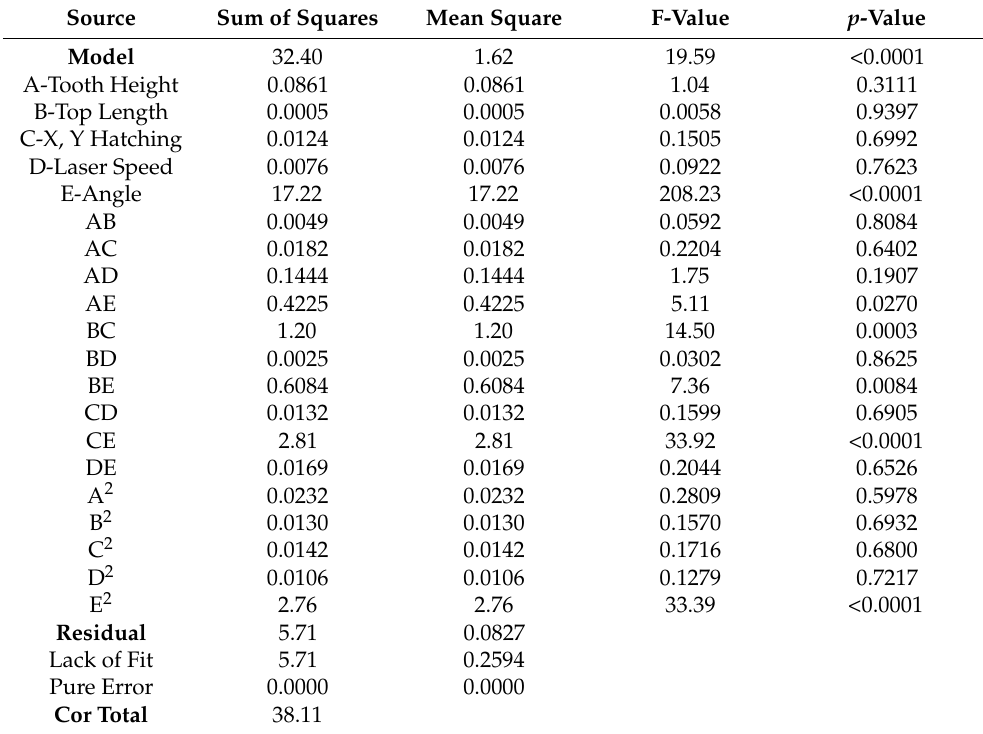
Table 8. ANOVA results for the quadratic model of Warping